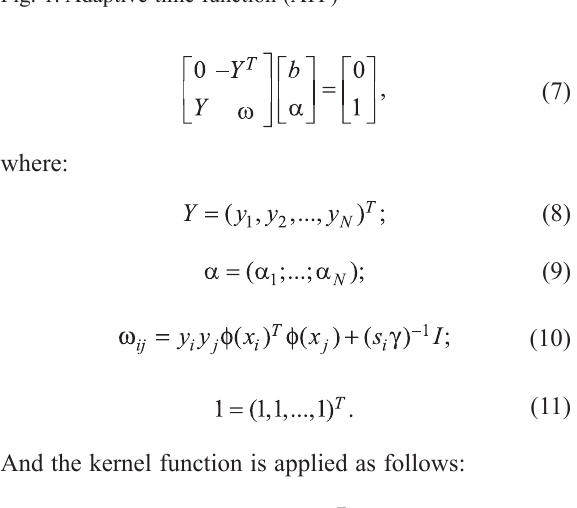
Fig. 1. Adaptive time function